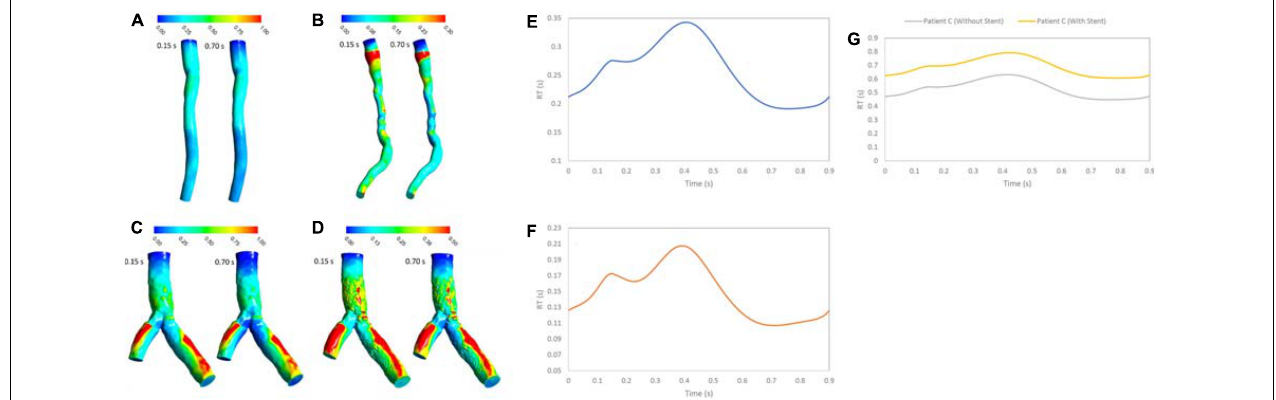
FIGURE 7 | RT (s) (A) for patient A, (B) for patient B, (C) for patient C without stent, and (D) with stent during both systole (0.15 s of pulse) and diastole (0.7 s of pulse) (E) RT (s) on wall for patient A, (F) RT (s) on wall for patient B, and (G) RT (s) on wall for patient C in a cardiac